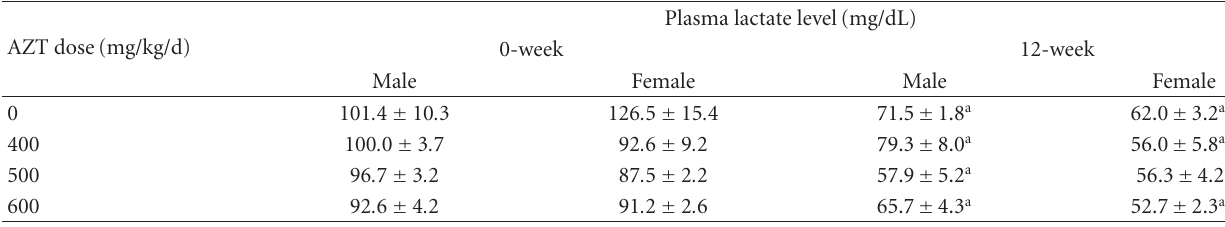
Table 2: Plasma lactate levels in B6C3F 1 mice.